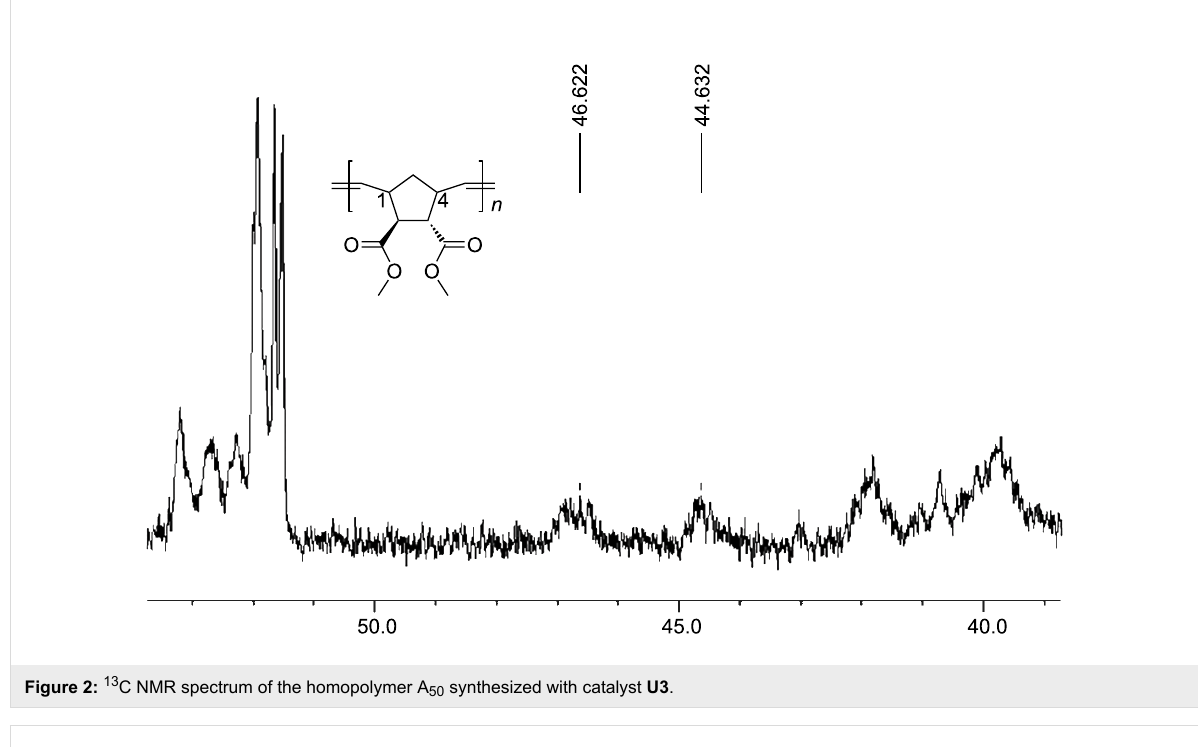
Figure 2: 13 C NMR spectrum of the homopolymer A 50 synthesized with catalyst U3 .